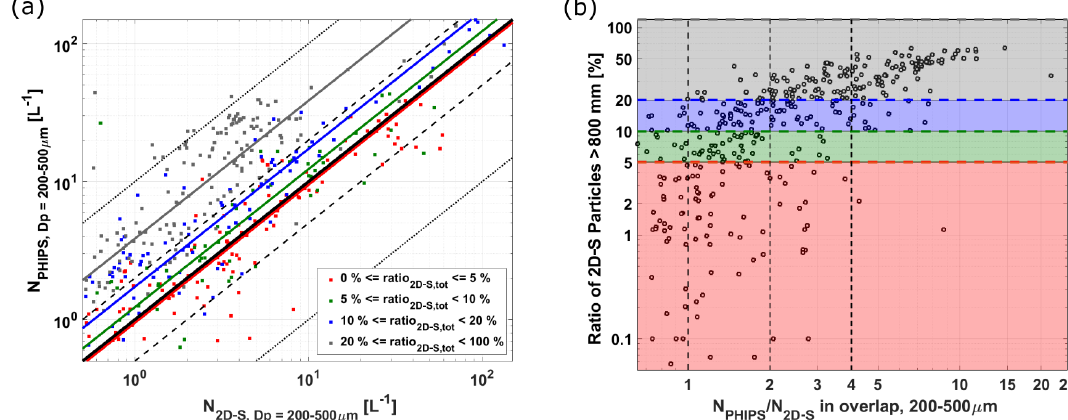
Figure 12. (a) Comparison of the total number concentrations of 2D-S and PHIPS. Each point is averaged over 30s. The color code is based on the ratio of large 2D-S particles with D max ≥ 800µ m . The thick black line marks the 1 : 1 line; the dashed and dotted lines are a factor of 2 and 10. (b) Correlation of the ratio of number concentrations of PHIPS and 2D-S and the presence of large 2D-S particles. The horizontal line marks the 10% threshold. The color code is the same as in (a)